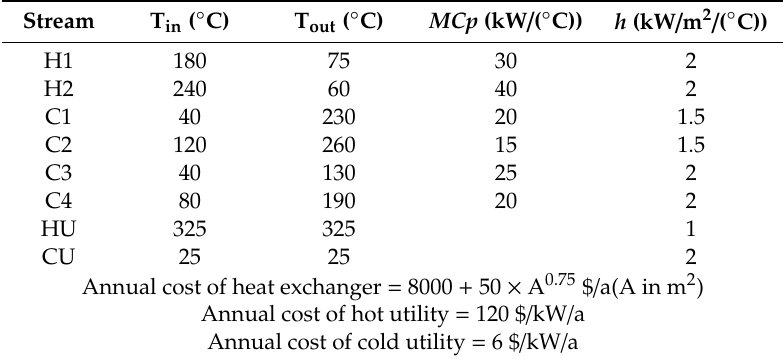
Table 3. Stream, cost, and parameters of case